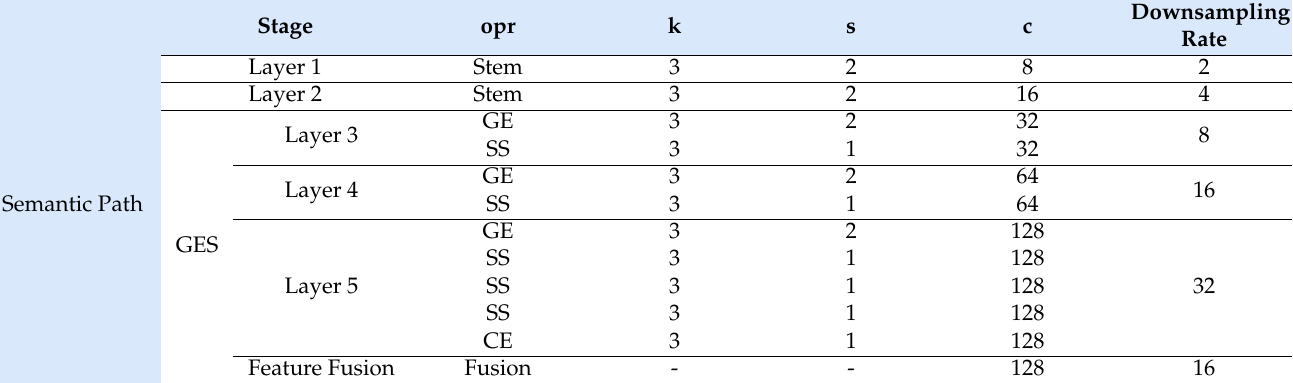
Table 2. Illustration of instantiation of the Semantic Branch. Each layer contains one or more operations (GES: gather–expand–search layer; GE: gather-and-expand bottleneck; SS: search-space bottleneck; CE: context embedded block; Fusion: feature fusion block). Each operation (opr) has a kernel size k, stride s, output channels c and a downsampling